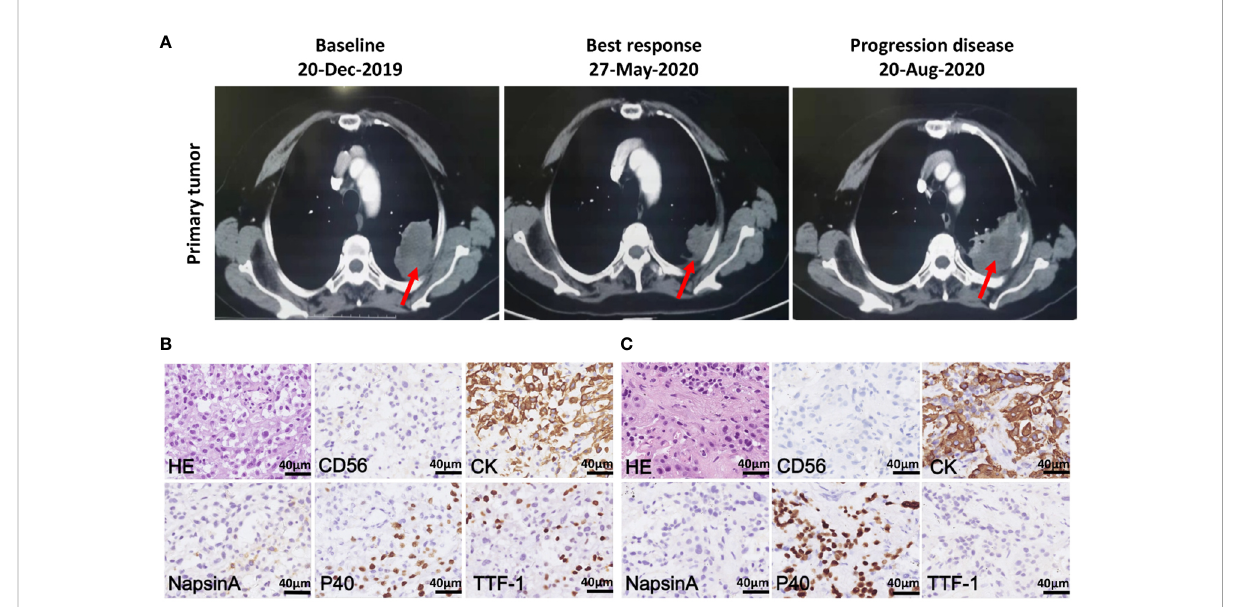
FIGURE 1 Chest computed tomography (CT) scans and histopathology of patient tumor before and after crizotinib treatment. (A) CT scans of the primary tumor of patient at baseline (left), best response (middle) and progression disease (right) after crizotinib treatment. Red arrows point to malignant loci. (B) H&E staining and IHC staining of the tumor biopsies from patient before crizotinib treatment, which was CD56 negative, CK positive and partially positive for TTF1, P40 and NapsinA; the scale bar represents 40 m m. (C) H&E staining and IHC staining of tumor biopsy specimens from a patient in disease progression, which was negative for CD56, NapsinA and TTF-1, positive for CK and P40; the scale bar represents 40 m